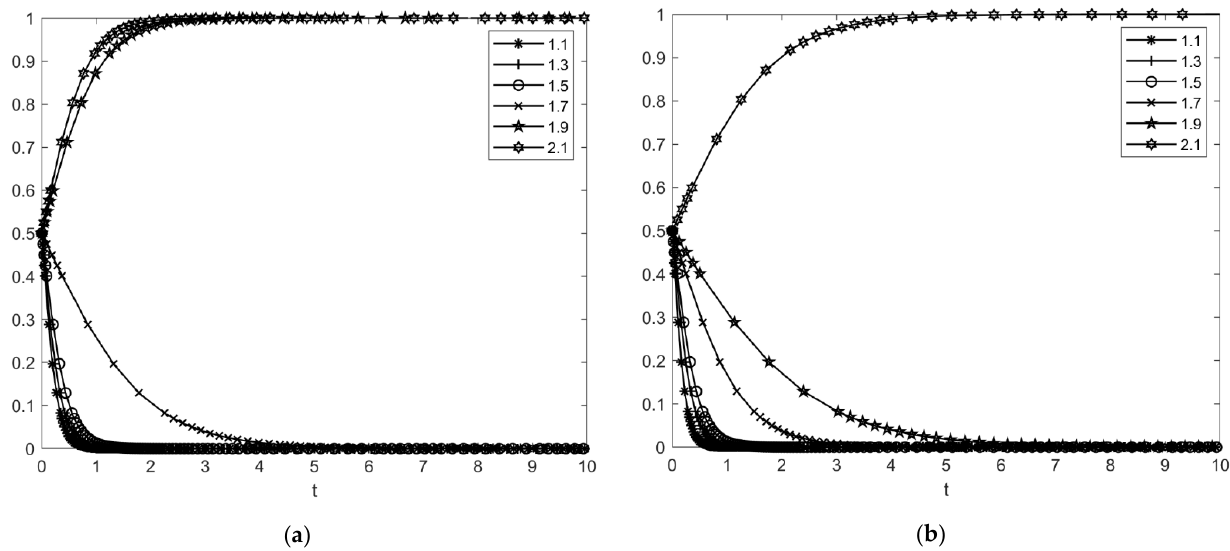
Figure 7. Sharing Level. ( a ) β = 0.3 ( construction enterprise 1), ( b ) β = 0.7 (construction enterprise 1